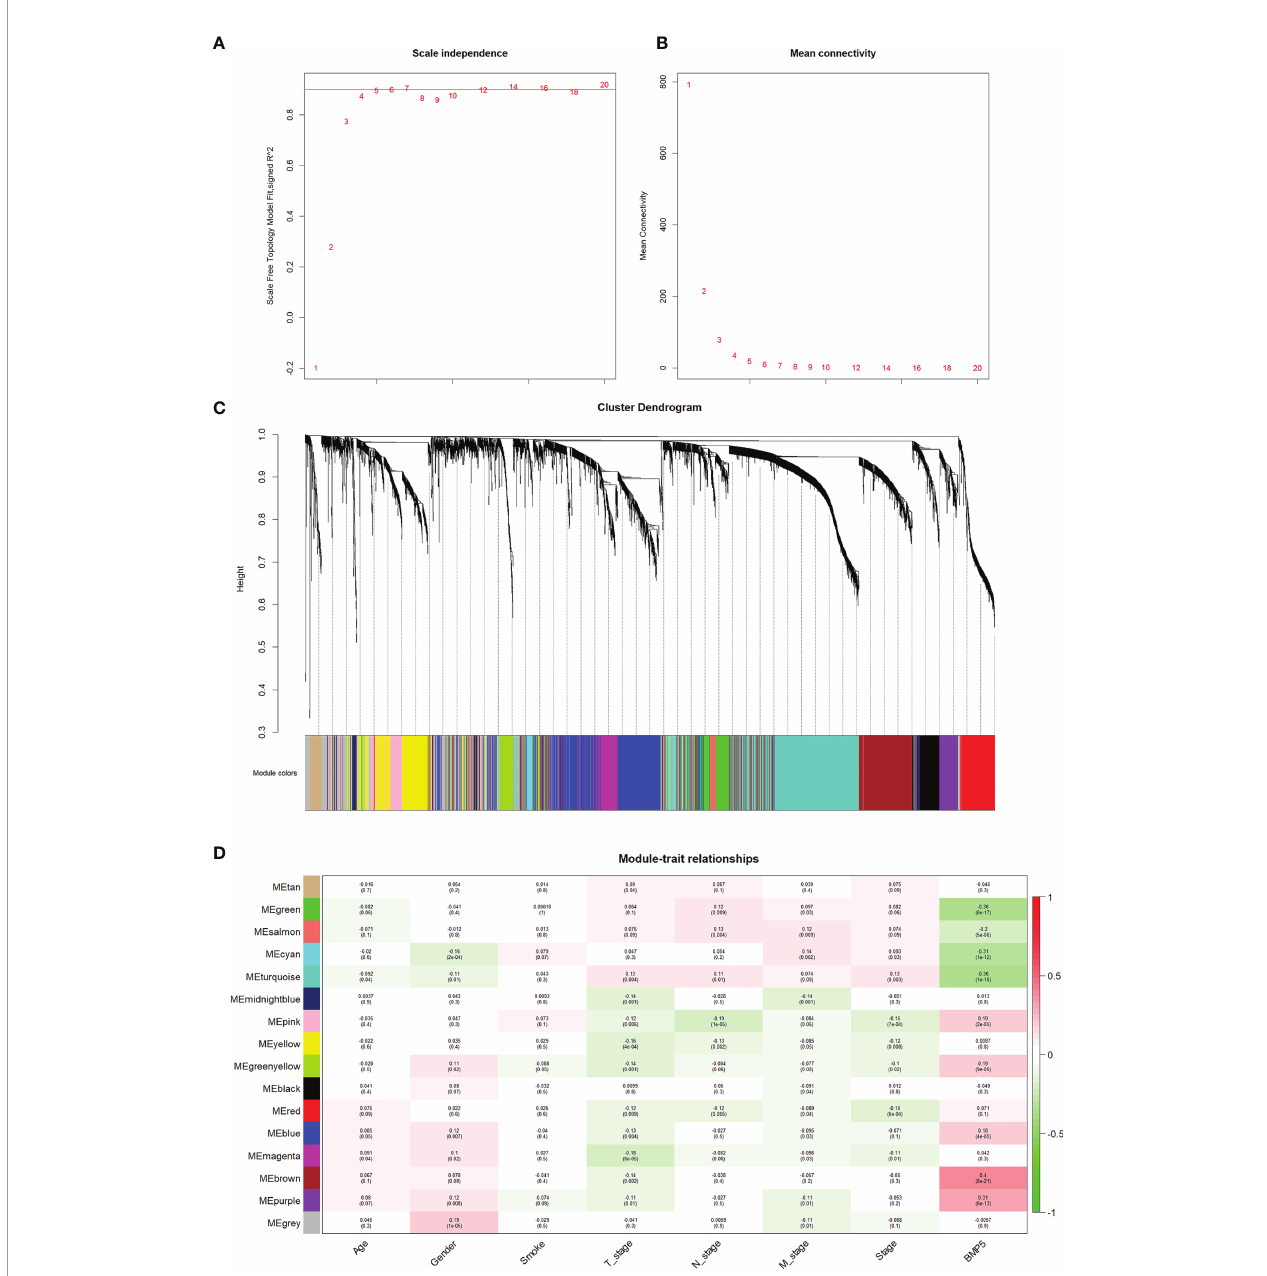
FIGURE 5 | The identi fi cation of modules and their correlation with phenotypes particularly BMP5 expression in WGCNA. (A, B) The scale-free index and the average connectivity were both calculated under different b (the number in the fi gure indicates the corresponding soft threshold power). The approximate scale-free topology was achieved at a soft threshold power of 4. (C) Gene clustering tree diagram of 16 modules based on the common topological overlap, and each color module represents a module that contains a set of highly connected genes. (D) Correlation heatmap of different modules with various phenotypes including BMP5 expression. The numbers in brackets indicate the p -value, and the numbers without brackets indicate the